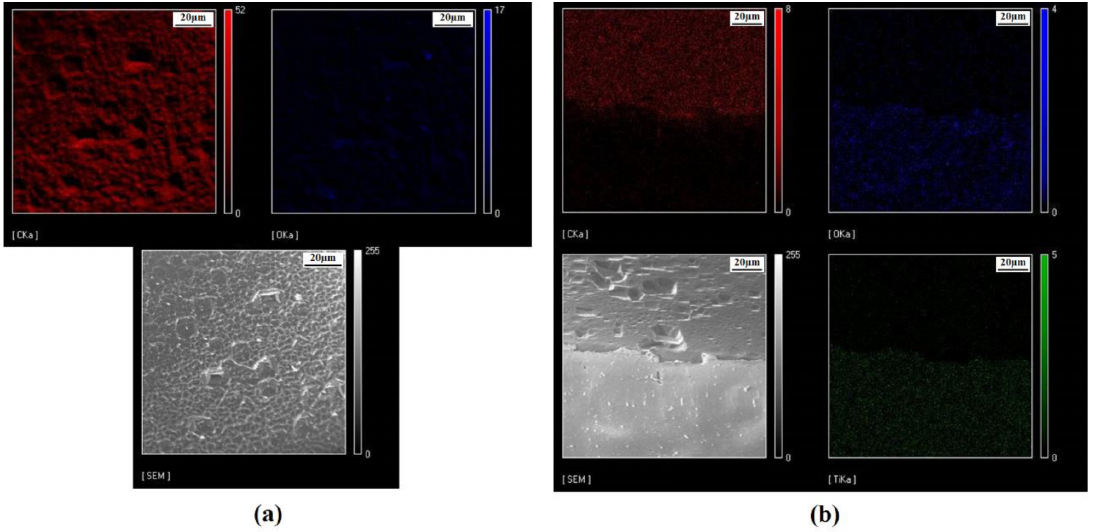
Figure 10. Mapping by EDS for (a) uncoated diamonds and for (b) Ti-coated diamonds, after heat treatment during 180